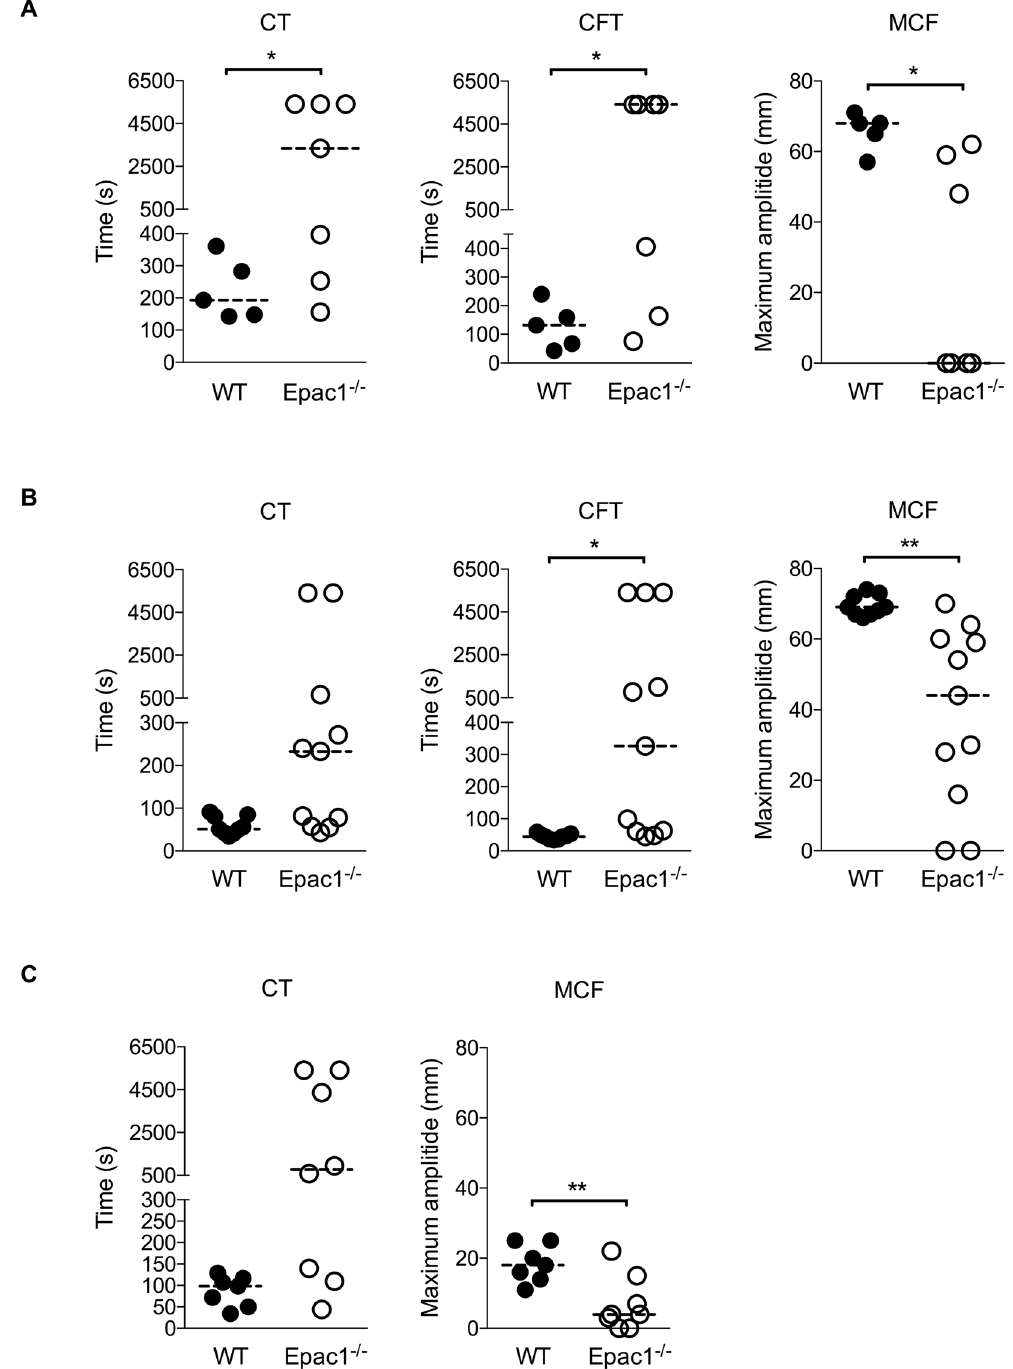
Figure 5. Epac1 − / − mice exhibit a delayed rate of clot formation and fragile clot stability ex vivo . ROTEM characterization of the coagulation process in citrated whole blood from WT and Epac1 − / − mice. Activated CT: clotting time i.e., the latency until the clot reaches a firmness of 2 mm, CFT: clot formation time and MCF: maximum clot firmness in mm was assessed by ROTEM assays ( A ) INTEM, ( B ) EXTEM and ( C ) FIBTEM. In FIBTEM assays the actin polymerization and platelet activation blocker cytochalasin D is present. Each point represents the measurements of one mouse. The horizontal dotted lines represent the median, n = 5–11 mice per group. * P < 0.05, ** P < 0.01, Student’s